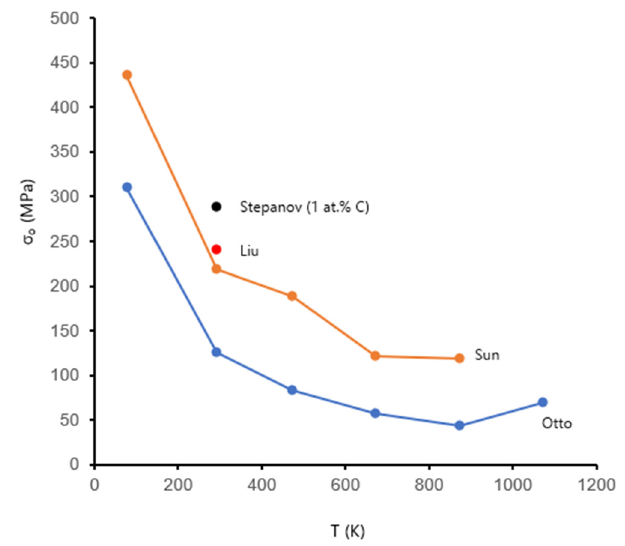
Figure 3. Graph of lattice resistance, σ 0 , versus temperature for undoped equiatomic CoCrFeMnNi, data from [18–20]; and for 1 at. % C-doped CoCrFeMnNi from Stepanov et al. [21].